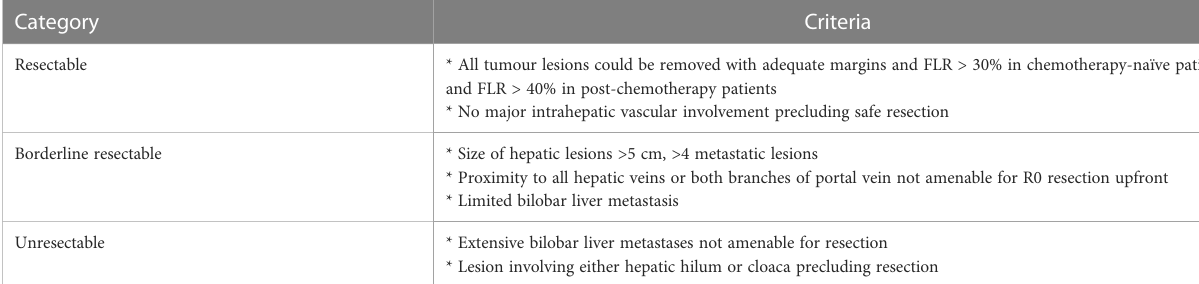
TABLE 1 Criteria for resectability of liver disease. Category